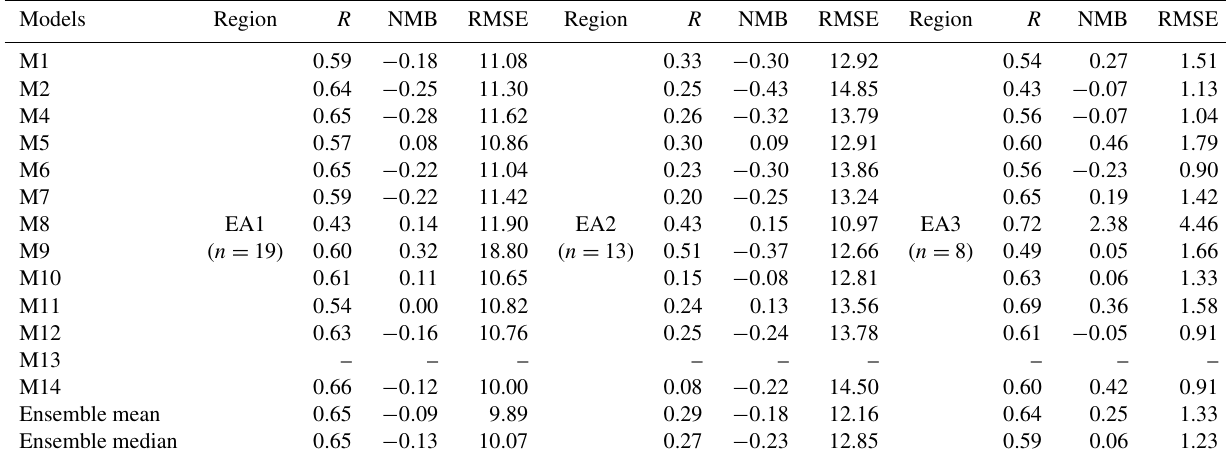
Table 4. Statistical analysis for surface NO 2 in three subregions over East Asia. R denotes the correlation coefficient, NMB is the normalized mean bias and RMSE is the root-mean-square error (units are